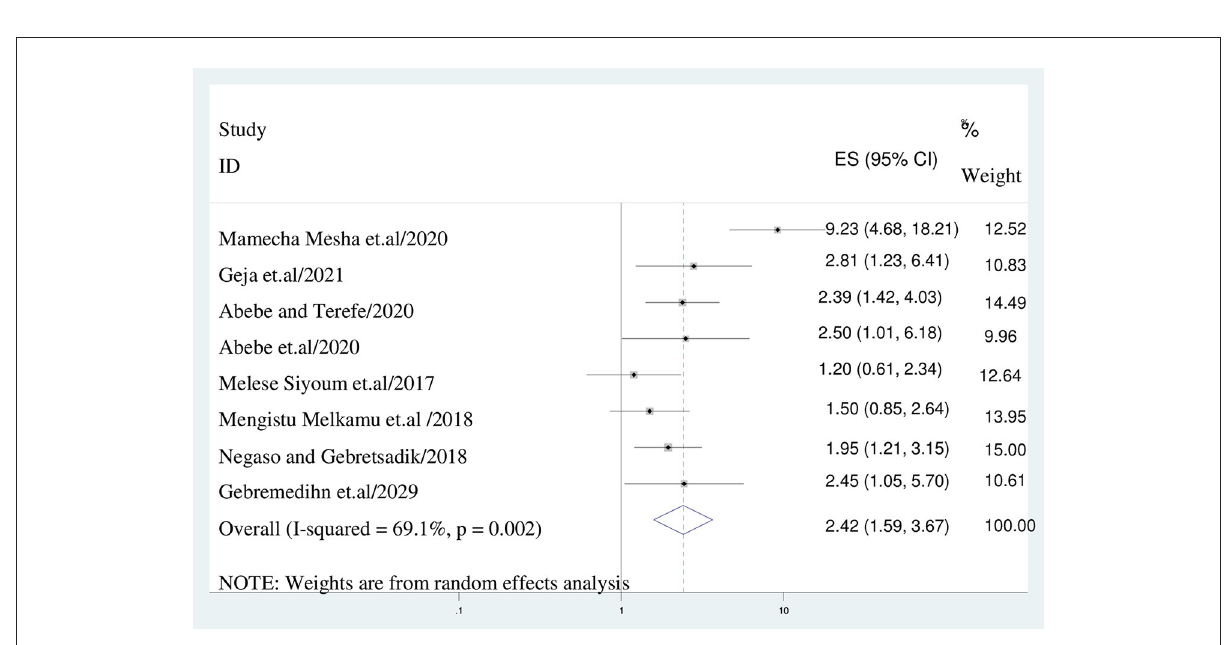
FIGURE5 The association between lack of counseling on side effects and discontinuation of long acting reversible contraception.